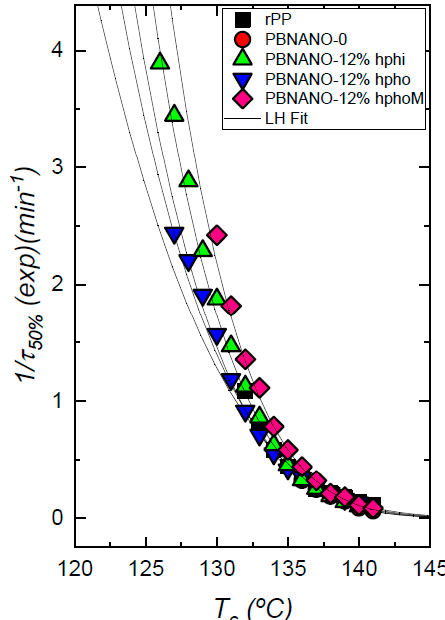
Figure 9. Overall crystallization rate of rPP and the rPP phase within the indicated PBNANOs as a function of crystallization temperature. Solid lines correspond to mathematical fits to the Lauritzen and Hoffman theory [41].